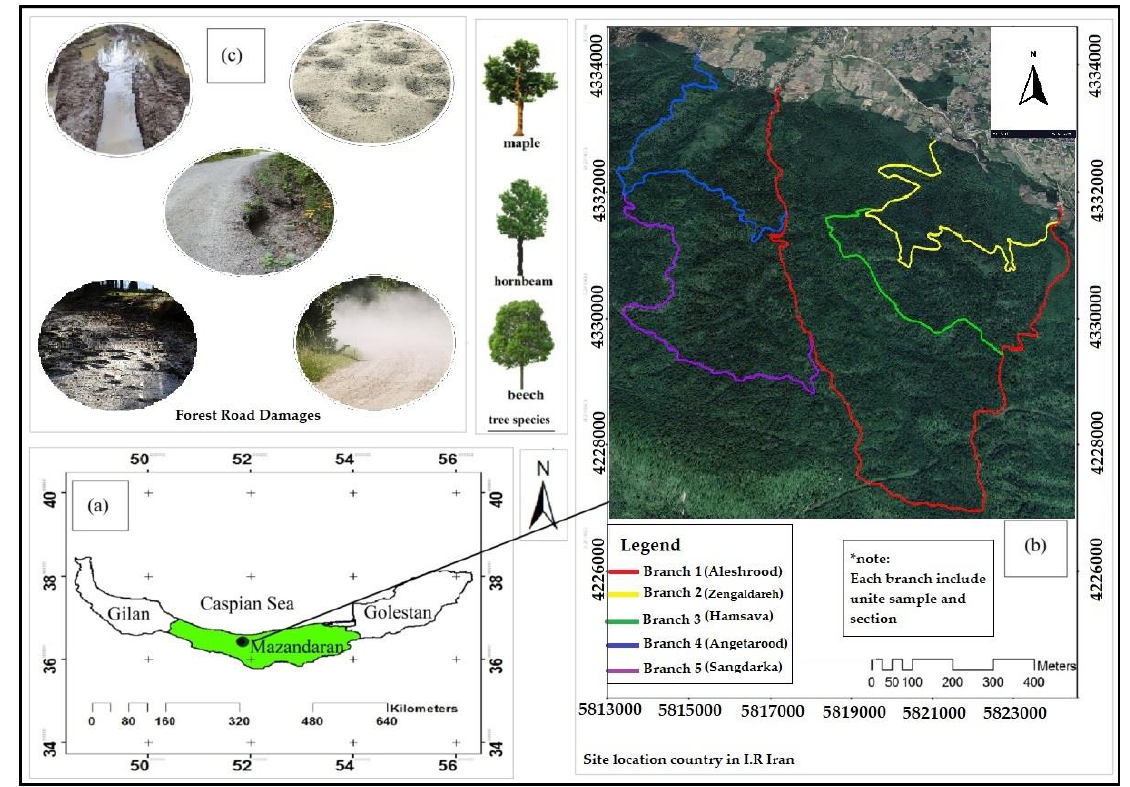
Figure 3. Location of the study site in the Central Caspian region of northern Iran ( a ). Study site, including different forest roads composition, including 1 to 3 degrees considered for 200 section, and a total of 3000 sample units considered in the forest ( b ). Major damages in forest road survey with tree species canopy on road ( c